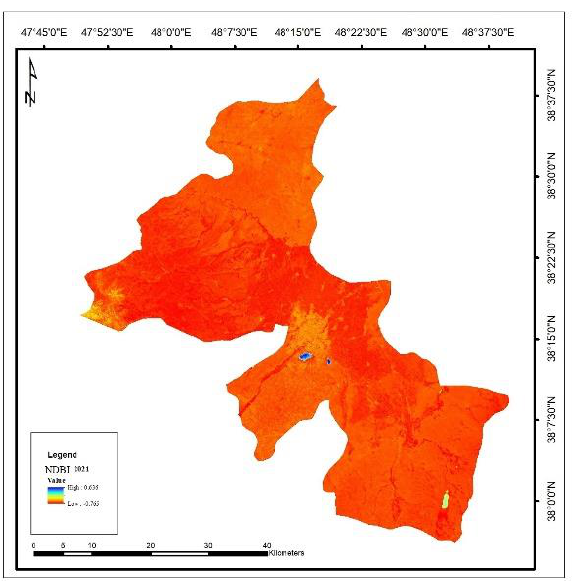
Figure 4. Normalized Difference Built-up index for the study area for 2021.